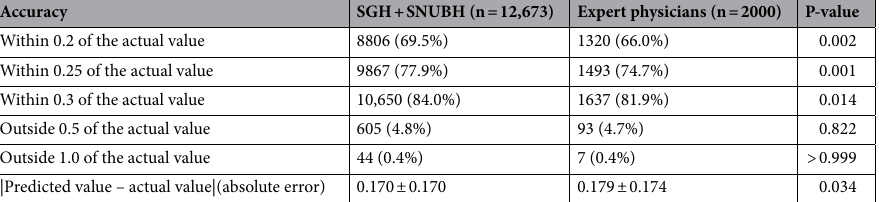
Table 1. The performance of the machine learning algorithm and expert physicians in predicting the 5th-day prothrombin time international normalized ratio (PT INR). The predictions were based on data from days 1–4.